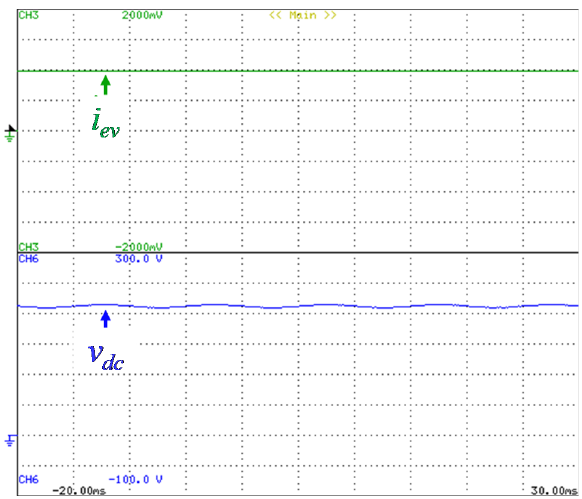
Figure 4. Experimental results during the MF-EVCS operation in G2V mode: ( a ) Harmonic spectrum of the ac-side current ( i evcs ); ( b ) Operating powers and total power factor.